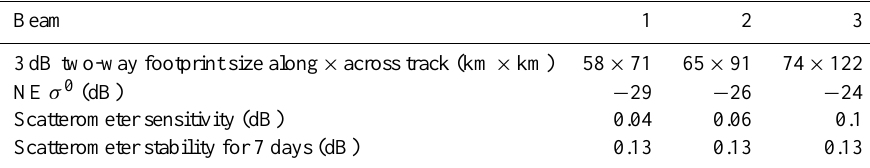
Table 2. Beam-dependent characteristics of the Aquarius L-band